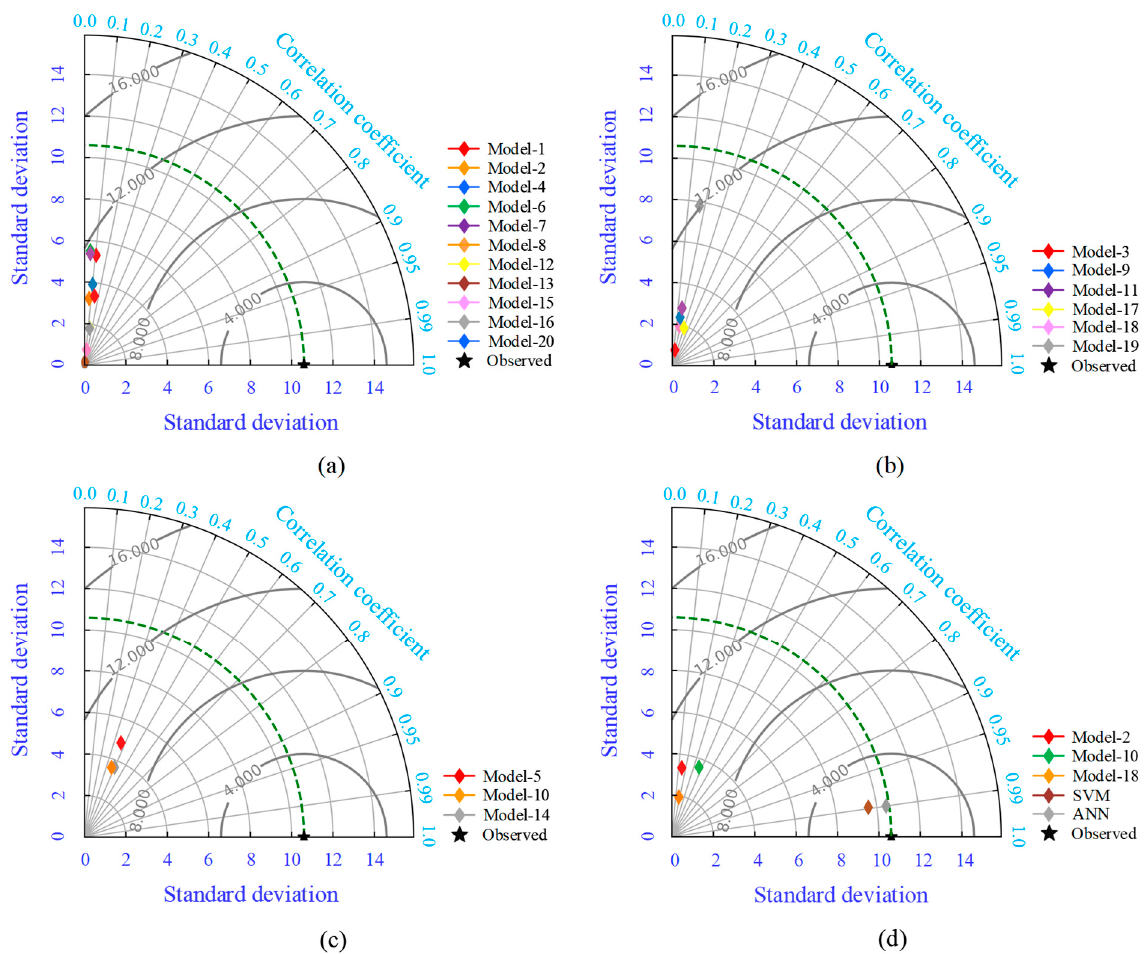
Figure 14. Taylor diagram for all groups; ( a ) Group-I, ( b ) Group-II, ( c ) Group-III, ( d ) Best model from each group, and proposed SVM and ANN